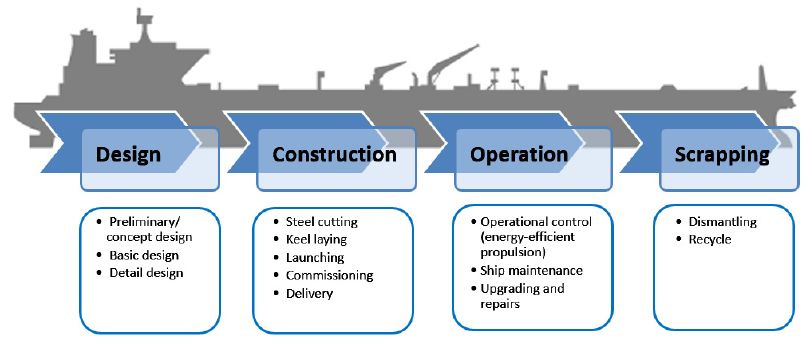
Figure 2. Ship lifecycle and key milestones.